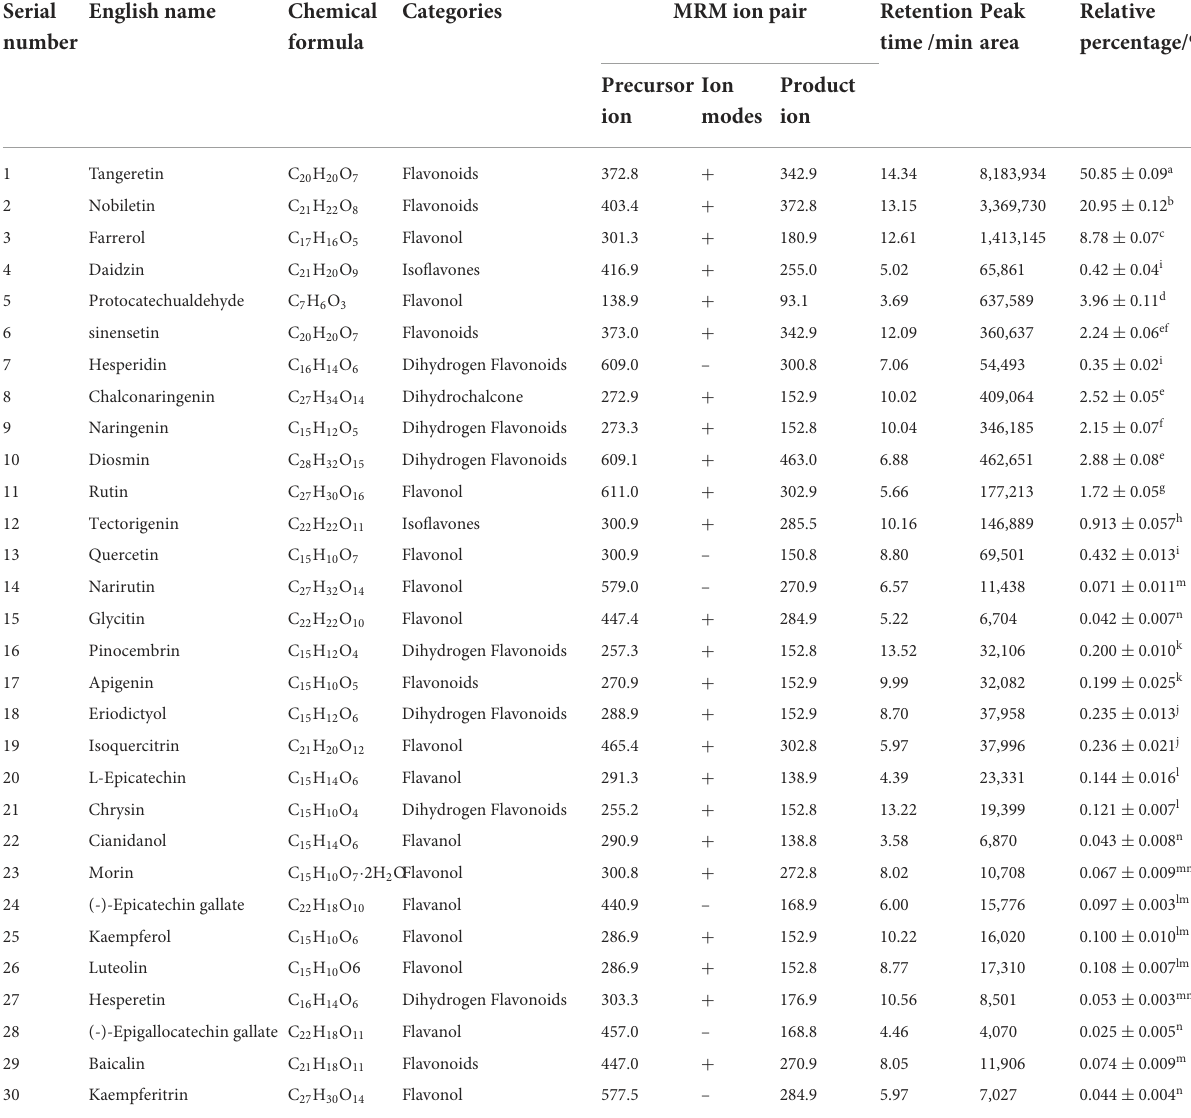
TABLE 4 Components and relative contents of total flavonoids purified from M. crystallinum